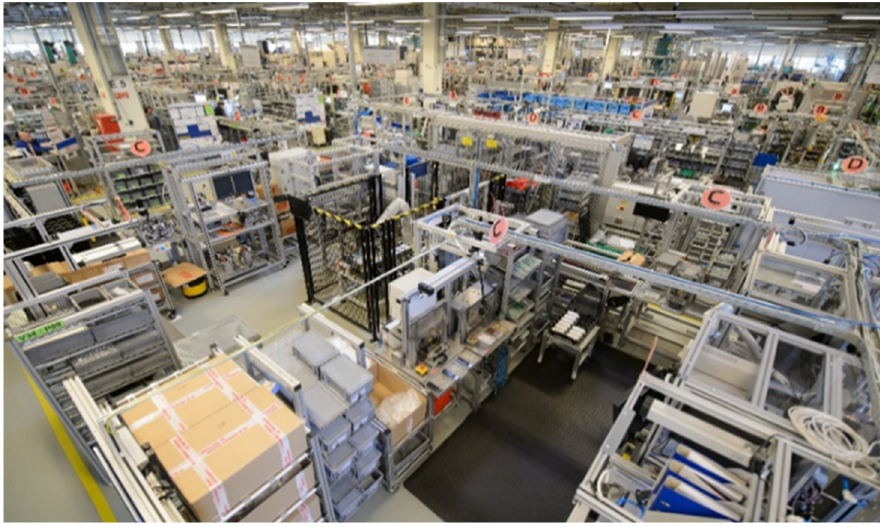
Figure 2. View of the shop floor.